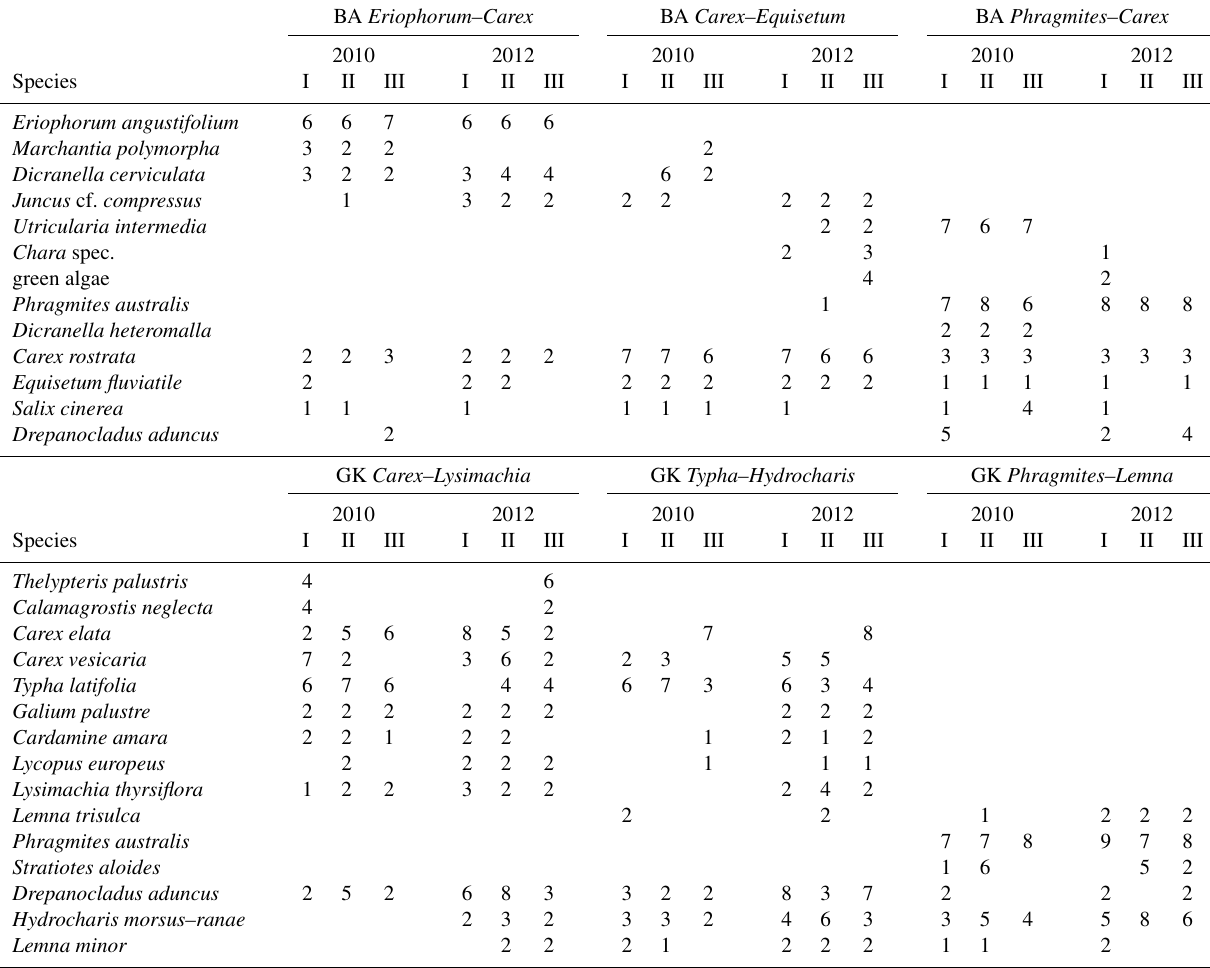
Table A1. Plant species cover of GHG measuring plots in summer 2010 and